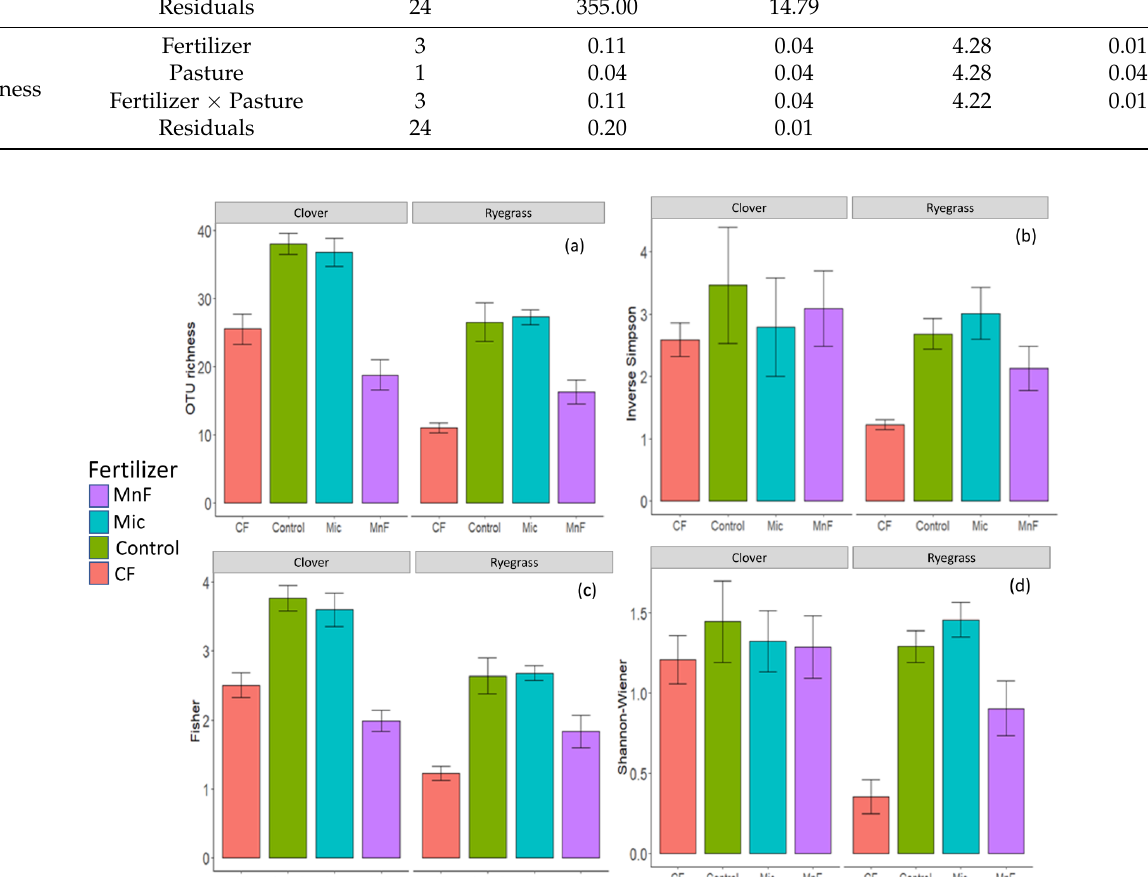
Figure 6. AM fungal community richness and diversity estimators: ( a ) observed OTU richness, ( b ) inverse Simpson index, ( c ) Fisher index and ( d ) Shannon–Wiener index for DNA fungal sequences from subterranean clover and annual ryegrass roots at 10 weeks. Treatments are chemical fertilizer (CF), rock mineral fertilizer (MnF), microbial inoculant (Mic) and untreated soil (control). Bars represent the mean for each treatment; error bars are the standard